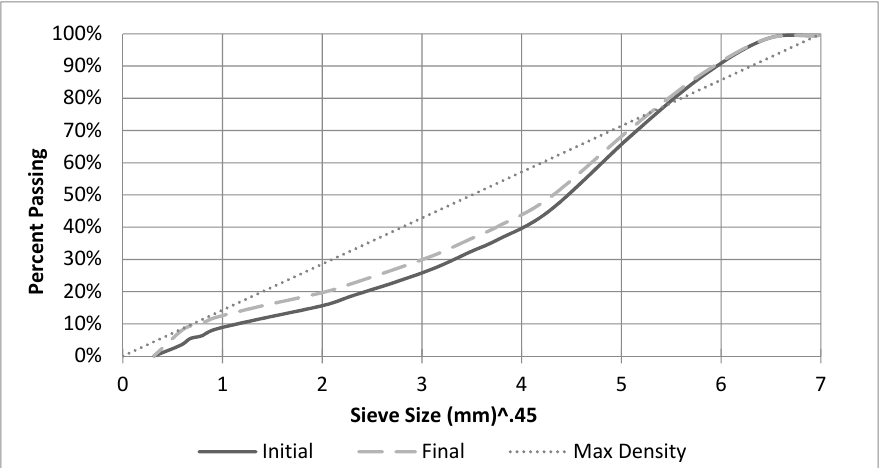
Figure 2. Average gradation changes of low-quality aggregate samples.